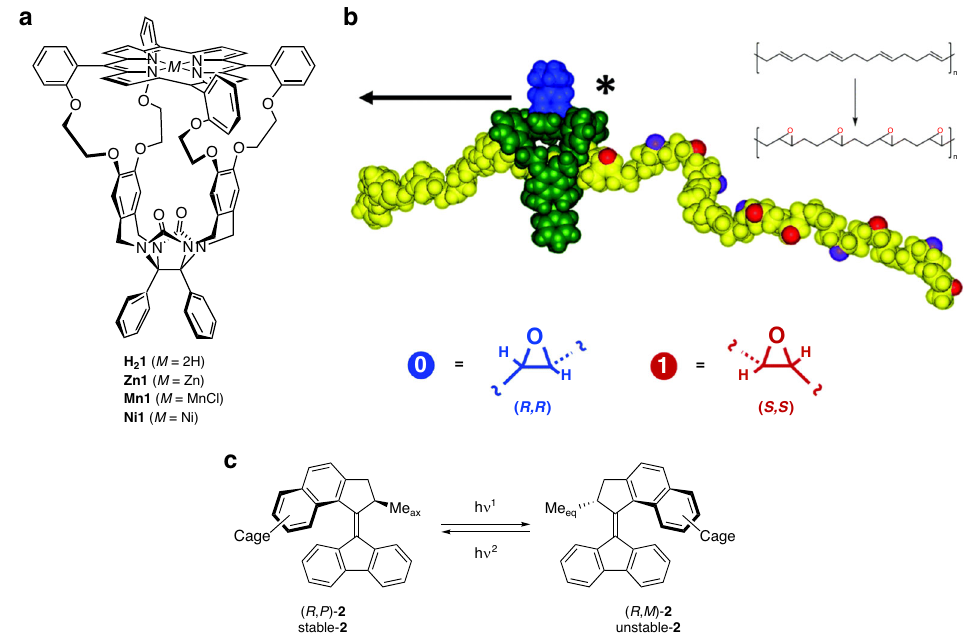
Fig. 1 Structure of compounds. a Molecular structure of porphyrin cage compounds H 2 1 , Zn1 , Mn1 , and Ni1 . b Schematic representation of the process in which a chiral derivative of Mn1 (green) writes chiral epoxides (blue and red balls) on a polymer comprising ( E )-alkene functions (yellow) yielding a series of binary codes (reproduced with permission from the Royal Society of Chemistry) 17 . c Structure of the second-generation molecular motor 2